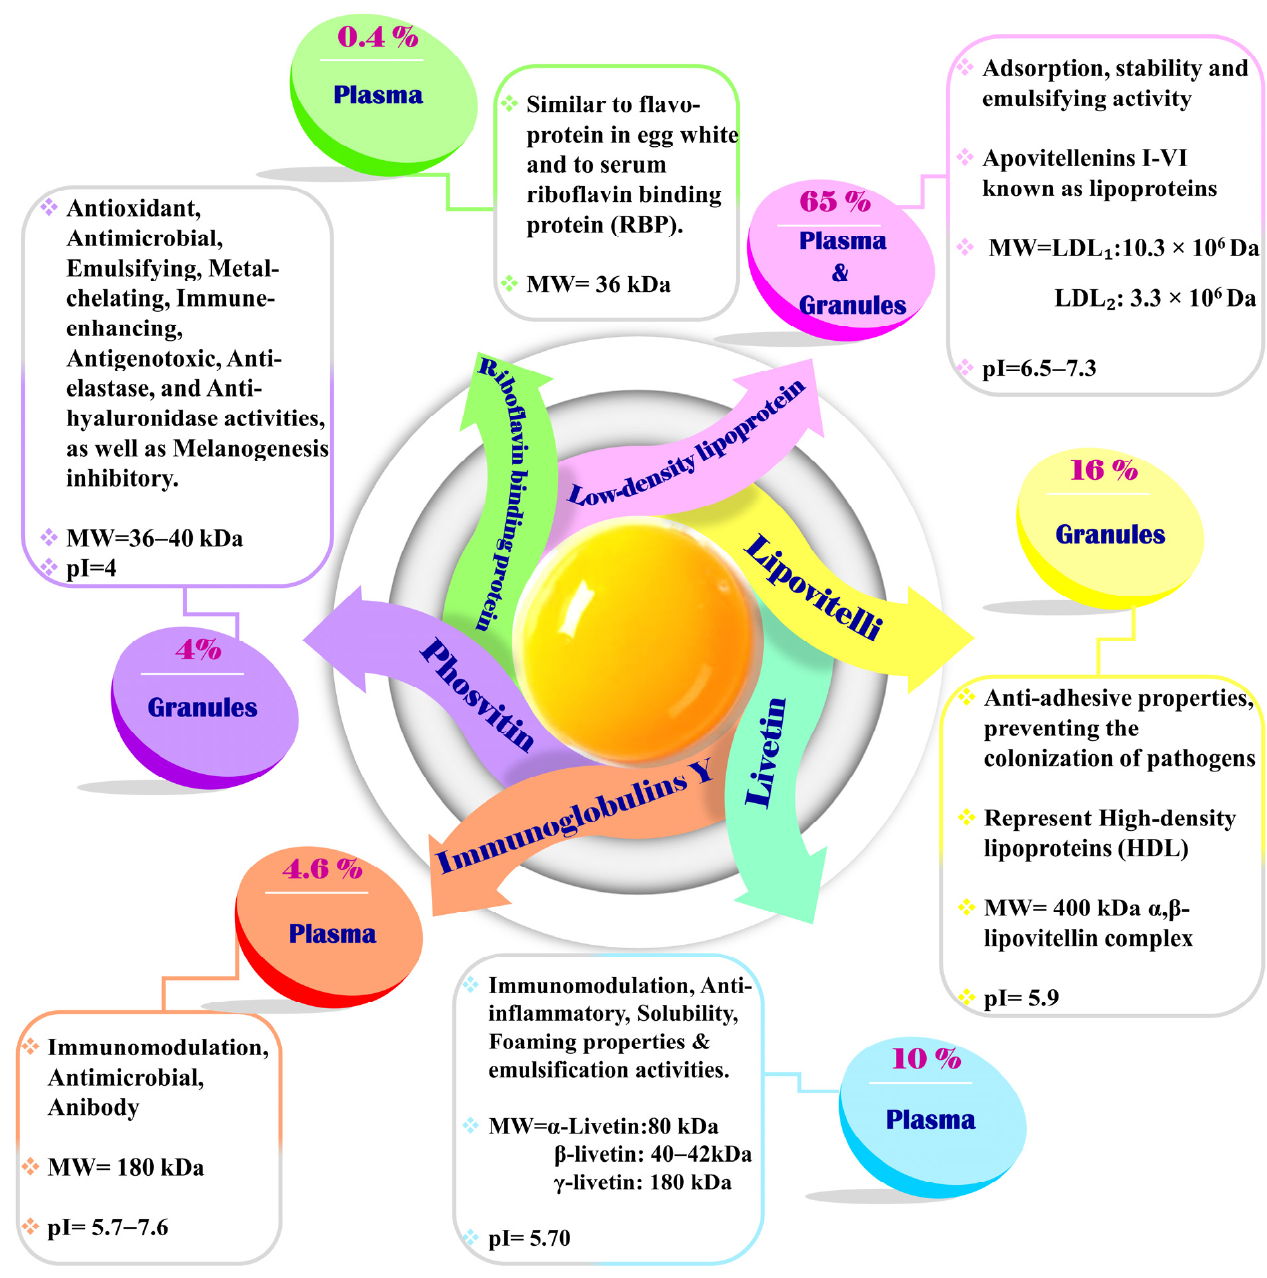
Figure 3. Percentage, location, Biological activity, molecular weight (MW), and isoelectric point (pI) of major egg yolk proteins.